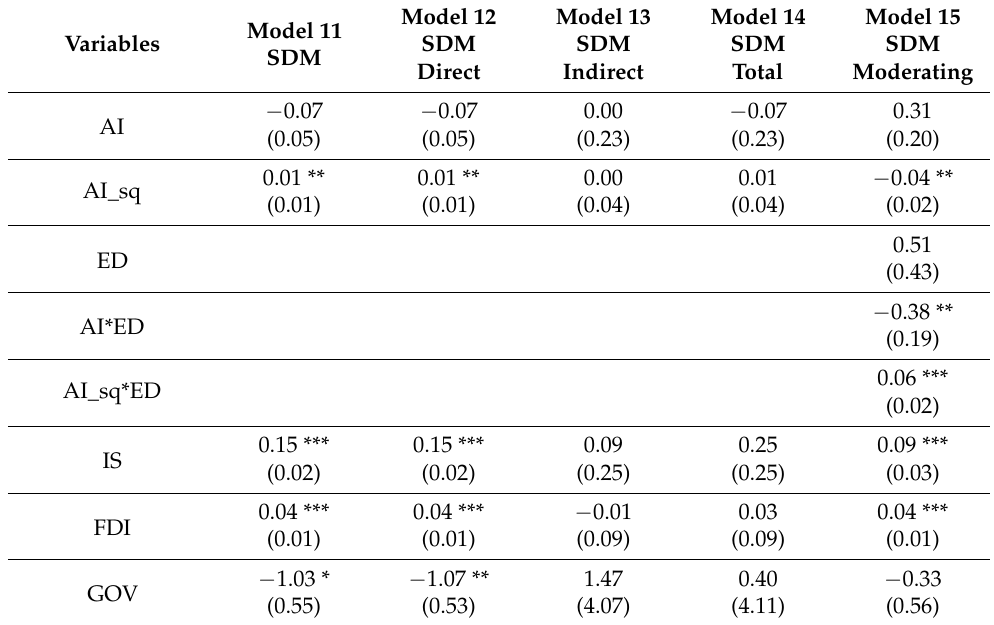
Table 7. Spatial basis regression